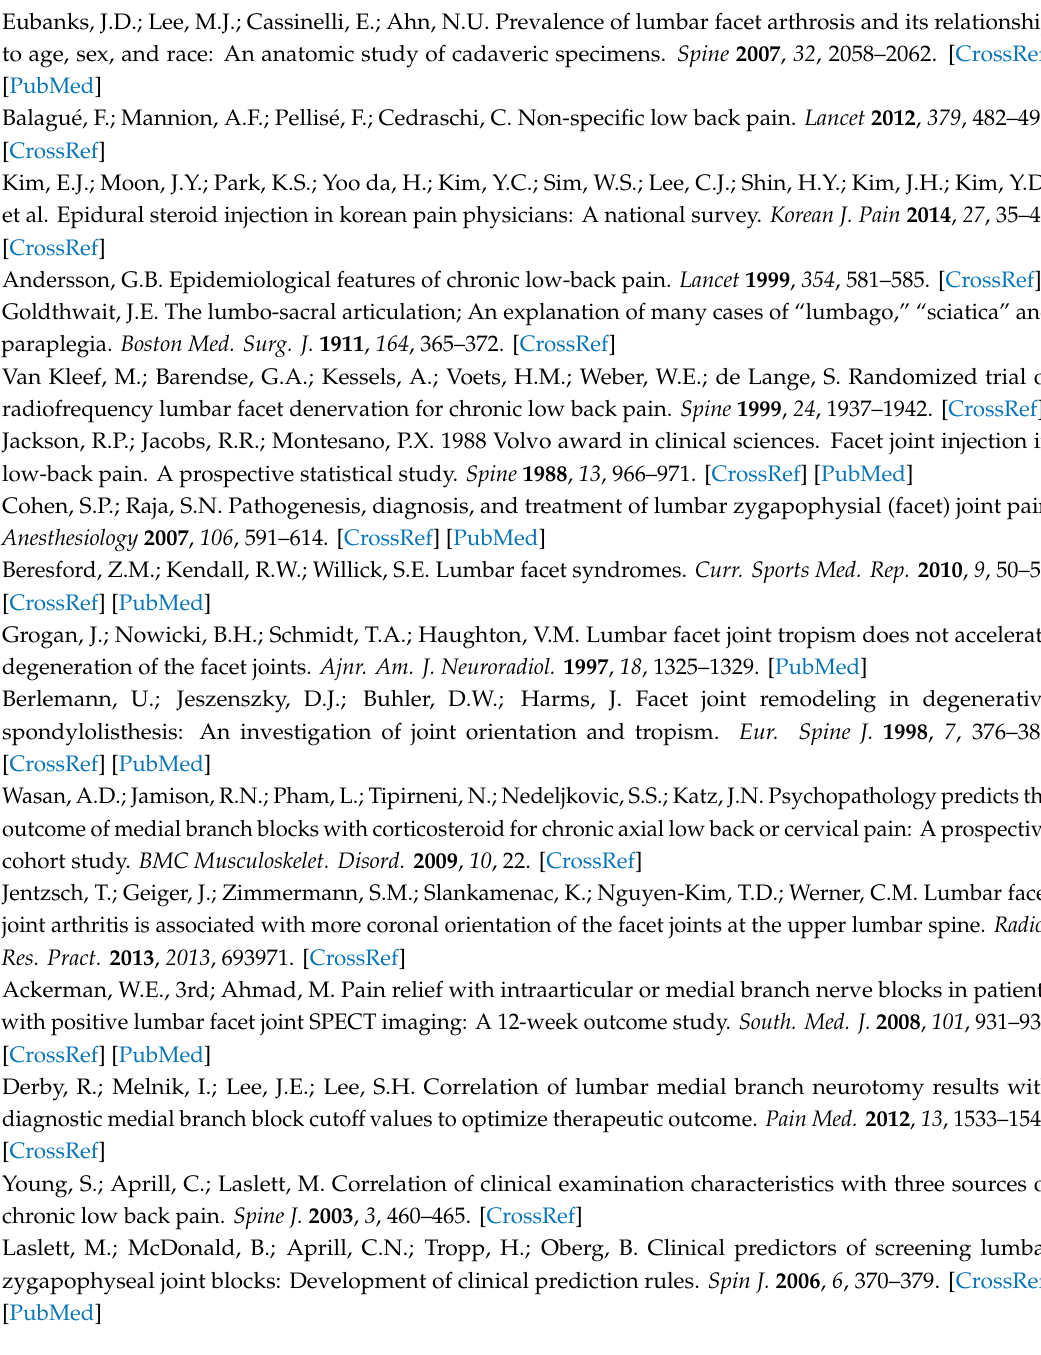
Table S1: Spearman’s rank correlation coe ffi cients and their statistical significance between the numeric rating scale and facet angle di ff erence at L3–4, disc height at